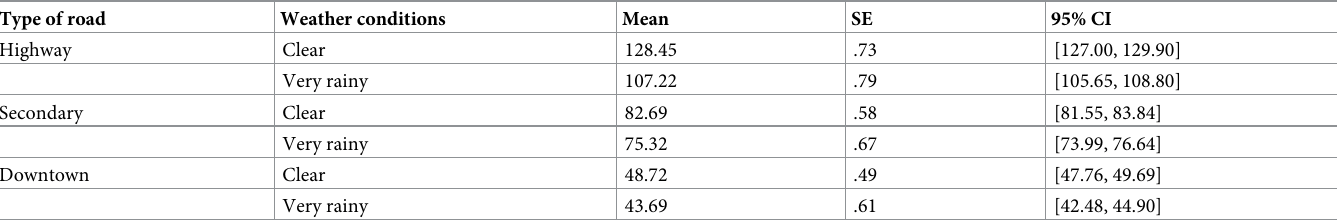
Table 4. Participants’ reported manual driving speed (in km/h) according to type of road × weather conditions. Type of road